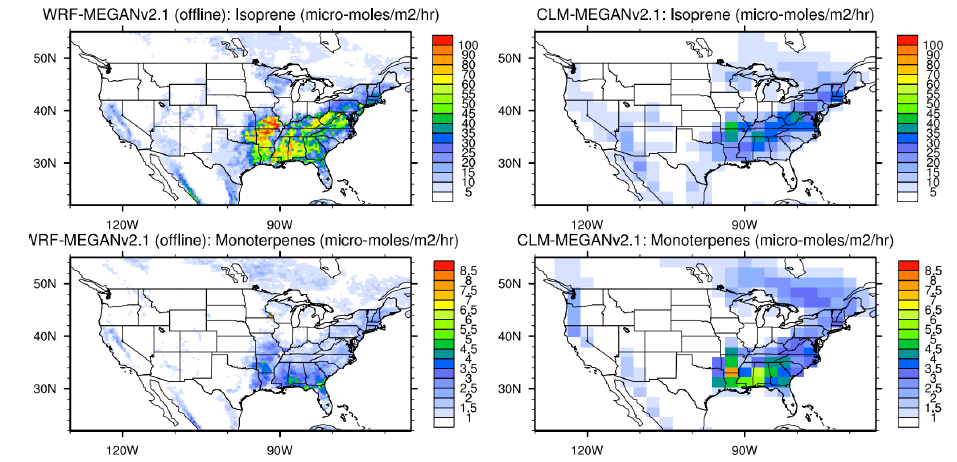
Figure 5: MEGAN2.1 estimates of U.S. isoprene and monoterpene emissions calculated using WRF-AQ and CLM4. Fig. 5. MEGAN2.1 estimates of US isoprene and monoterpene emissions calculated using WRF-AQ and